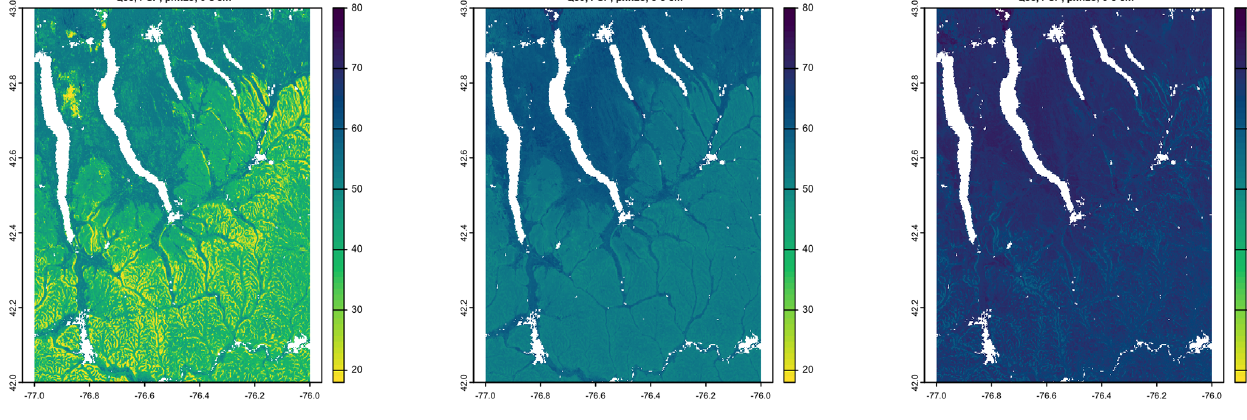
Figure 10. Quantiles of the prediction, PSP, for pH × 10 at 0–5cm. Note the unrealistically wide range at all locations and the fine patterning at the two extremes.